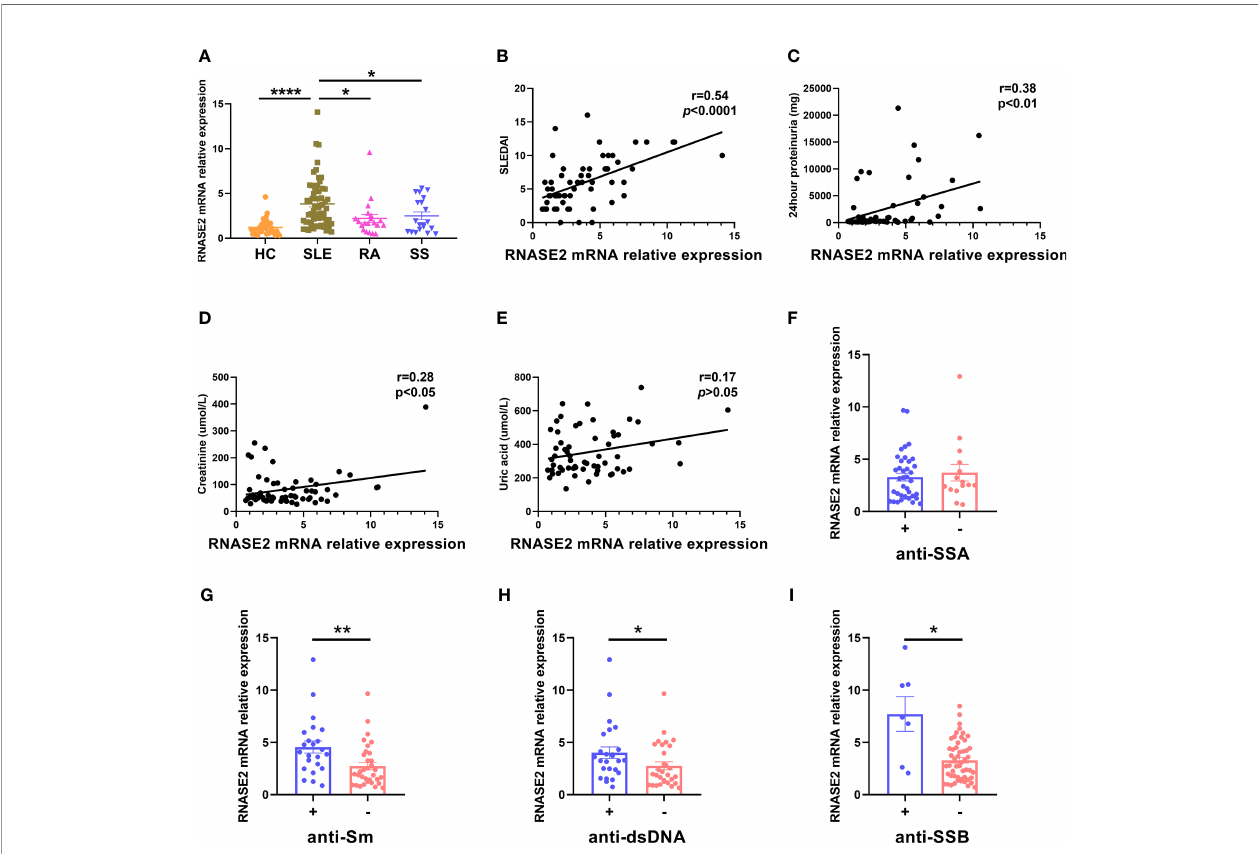
FIGURE 1 | Increased RNASE2 mRNA expression in PBMCs from SLE patients. (A) Detection of RNASE2 expression by real-time PCR in PBMCs from 37 healthy controls (HC), 60 SLE patients, 20 patients with rheumatoid arthritis (RA) and 20 patients with primary Sjögren ’ s syndrome (SS). (B – E) Associations of RNASE2 mRNA levels with SLE disease activity index (SLEDAI) score, the amount of 24hour proteinuria as well as the levels of serum creatinine and uric acid by the Pearson or Spearman correlation test. (F – I) RNASE2 mRNA expression in SLE patients with or without positive anti-SSA, anti-Sm, anti-dsDNA or anti-SSB antibodies. Data are presented as mean ± SEM, *p < 0.05, **p < 0.01, ****p <